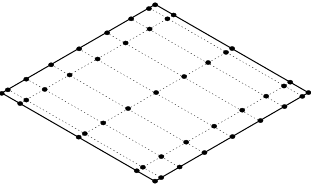
Figure 3. A node distribution in the plate element proposed by